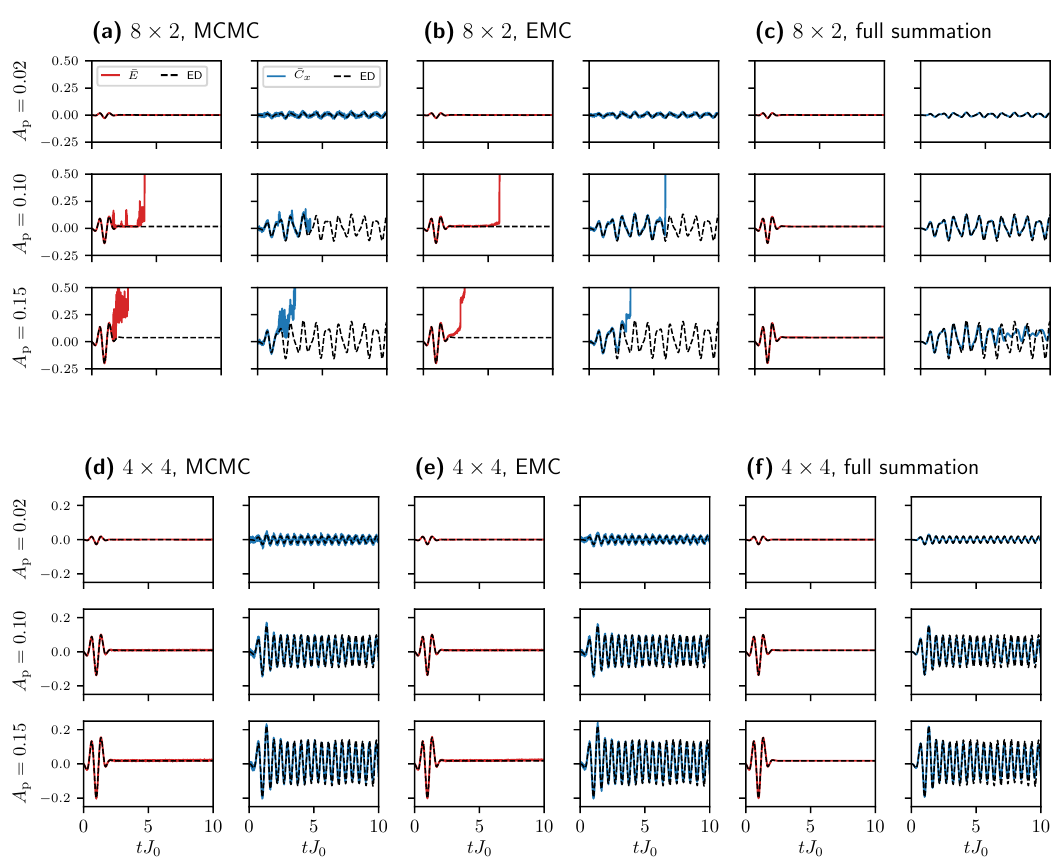
Figure 3: Time-dependent per-site energy change ¯ E ( t ) = [ 〈 ˆ H ( t ) 〉 − E ( 0 )] / N and ( t ) = C ( t ) − C ( 0 ) for the 8 × 2 ladder [ panels (a)– average x -bond correlation ¯ C x x x (c) ] and 4 × 4 square geometry [ panels (d)–(f) ] and varying pulse strengths A . The p trajectories have been obtained from t-VMC evolution using MCMC [ panels (a),(d) ] and EMC [ panels (b),(e) ] sampling as well as results based on full summation of the equations of motion [ panels (c),(f) ] ; see Sect. 3.1 for details. The dashed lines show ED results for reference. In all cases, a symmetric RBM with hidden unit density of α = 10 has been used. The initial state is the approximate ground state of the respective system obtained by stochastic reconfiguration and is the same for panels (a)–(c) and (d)–(f), respectively. In all cases, the equation of motion is evaluated by singular-value decomposition of S and applying a diagonal shift of ε = 10 − 3 (see Sect. 3.2 and Appendix D) for